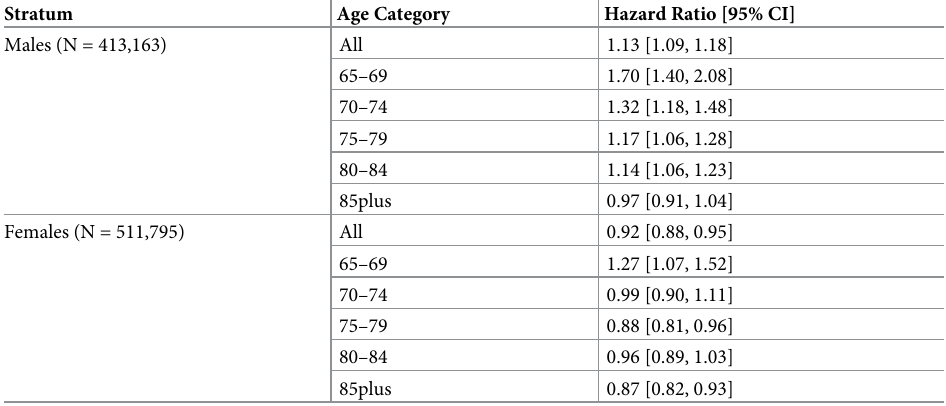
CI = Confidence Interval, models adjusted for Affluence index, number of children and number of comorbidities.